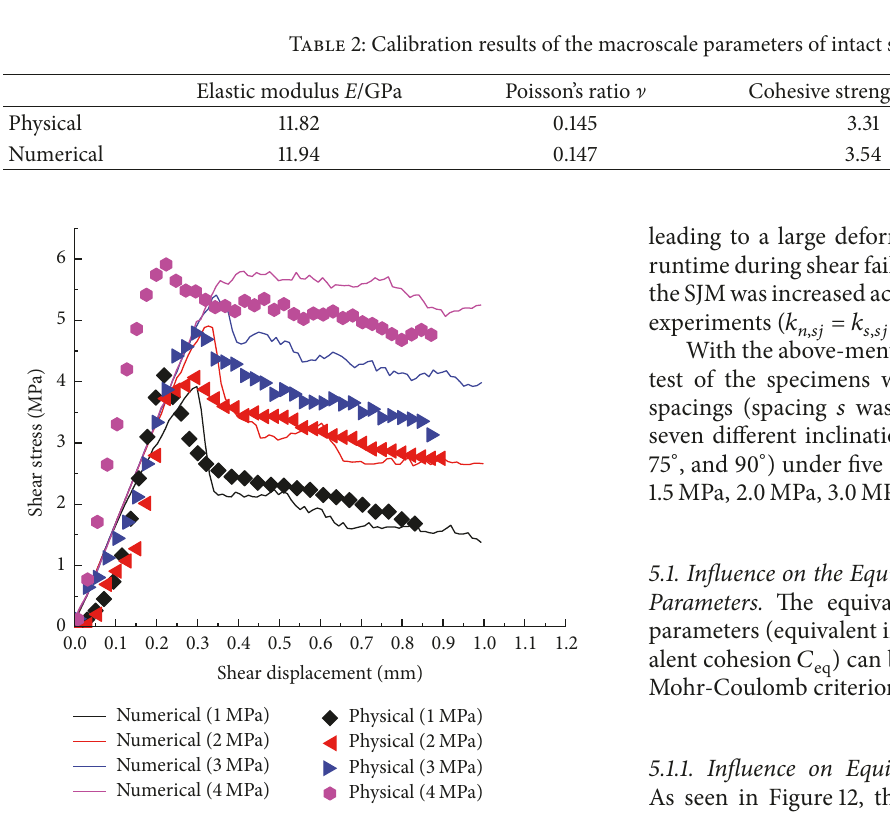
Figure 9: Curves of the results from the direct shear tests of the intact specimens under various normal